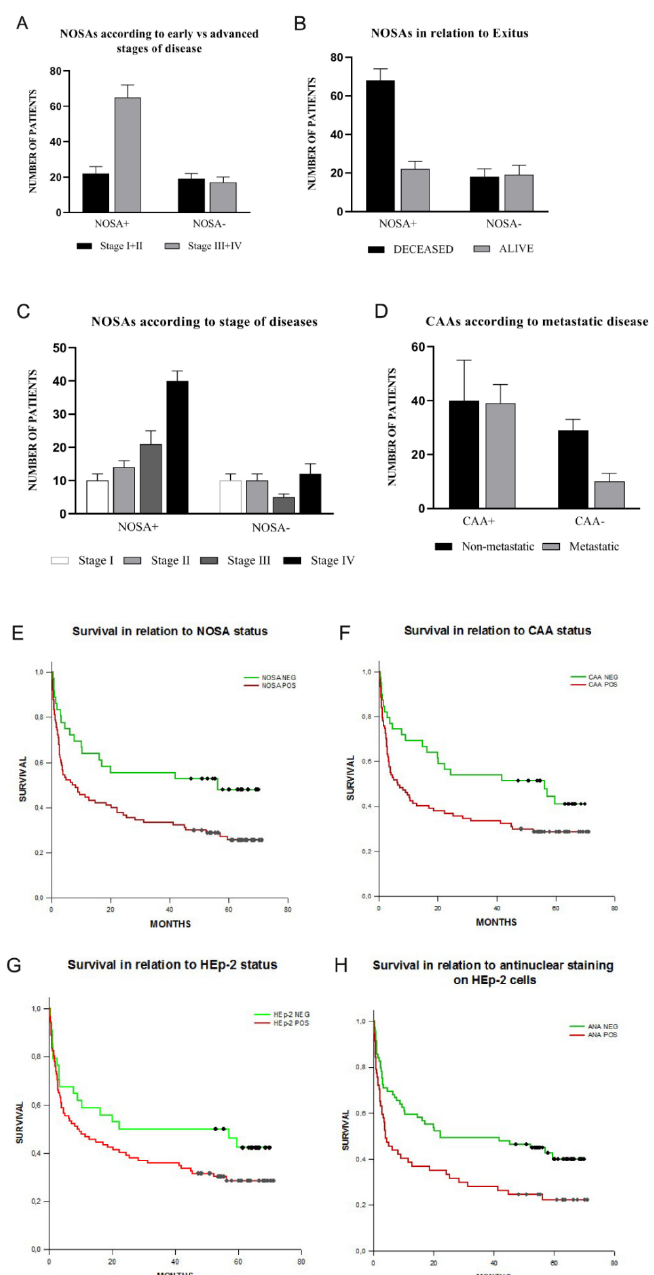
Figure 2. ( A ) The NOSA + (non-organ specific autoantibodies) condition significantly increases the odds of being in advanced stages by 2.71-fold (95% CI: 1.23–5.97) in the cohort of patients ( p = 0.021). ( B ) NOSA + status increases the odds of the exitus event by 2.75-fold (95% CI: 1.25–6.05, p = 0.019) ( C ). NOSA + status significantly increases in number from stage I to stage IV in the entire cohort of patients (Regression analysis, p < 0.05). ( D ) The CAA + (colon-related autoantibodies) status significantly increases the odds to have a metastatic disease by a factor of 2.49 (95% CI: 1.10–5.63, p = 0.043) among our study population. ( E ) Kaplan-Meier survival analysis for the five-year follow-up demonstarted better prognosis for NOSA- (non-organ specific autoantibodies) negative (Log-Rank test p = 0.015) and ( F ) CAA- (colon-specific autoantibodies) negative (Log-Rank test p = 0.038) pa-tients. ( G ) HEp-2 status did not reach the statistical significance for differences in survival (Log-Rank test p = 0.125). ( H ) The Log-Rank statistics for the survival curves confirmed a significant difference ( p = 0.009) in survival considering only antinuclear reactivity (dif-fuse or speckled) on HEp-2